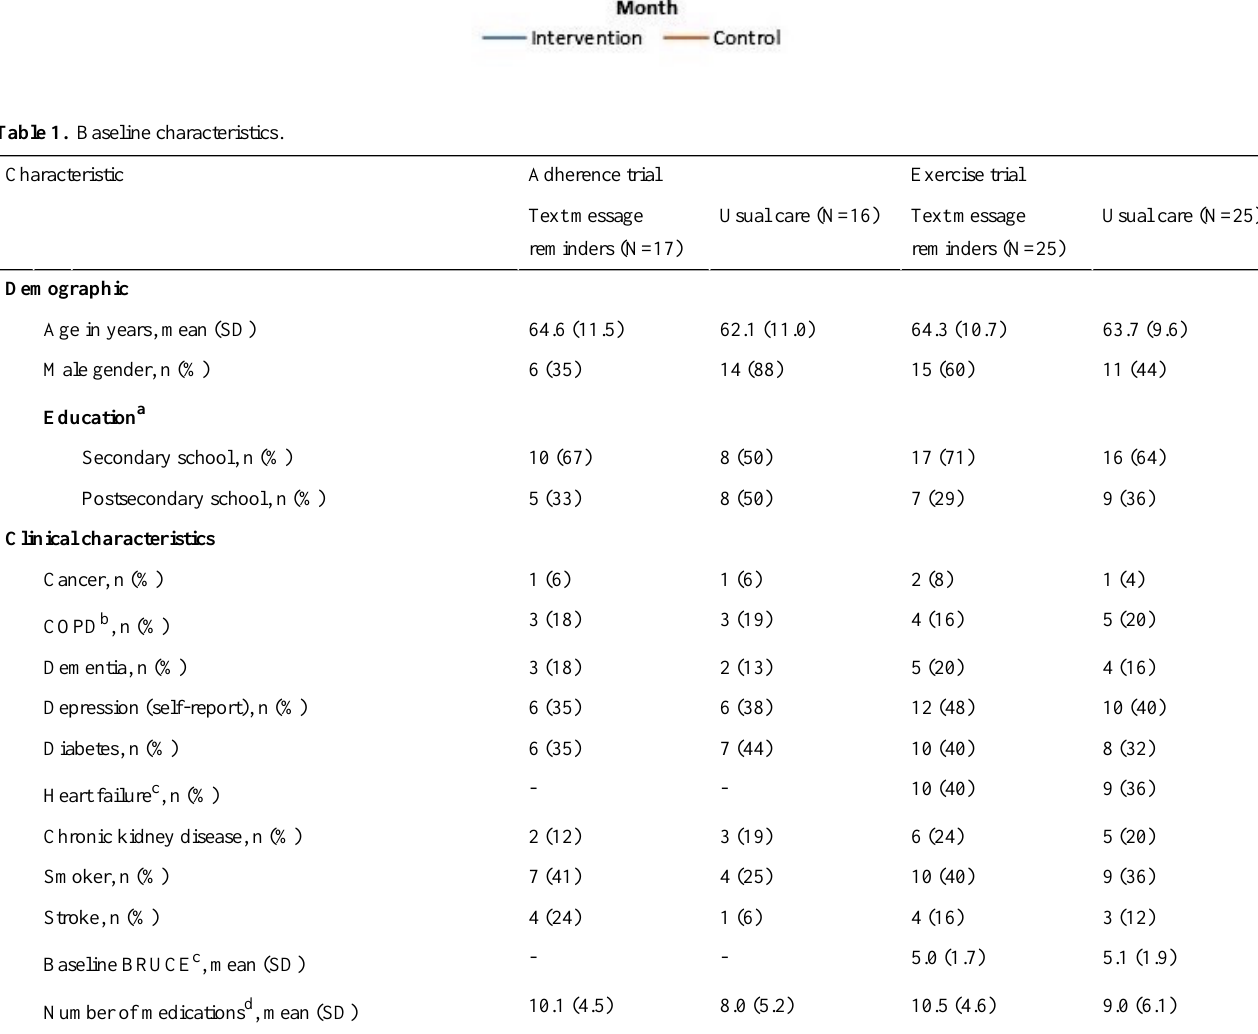
a 2 patients missing from Adherence trial, intervention arm; 1 patient missing from Exercise trial, intervention arm. b COPD: chronic obstructive pulmonary disease. c Not collected for Adherence trial. d 1 patient missing from Adherence trial, control